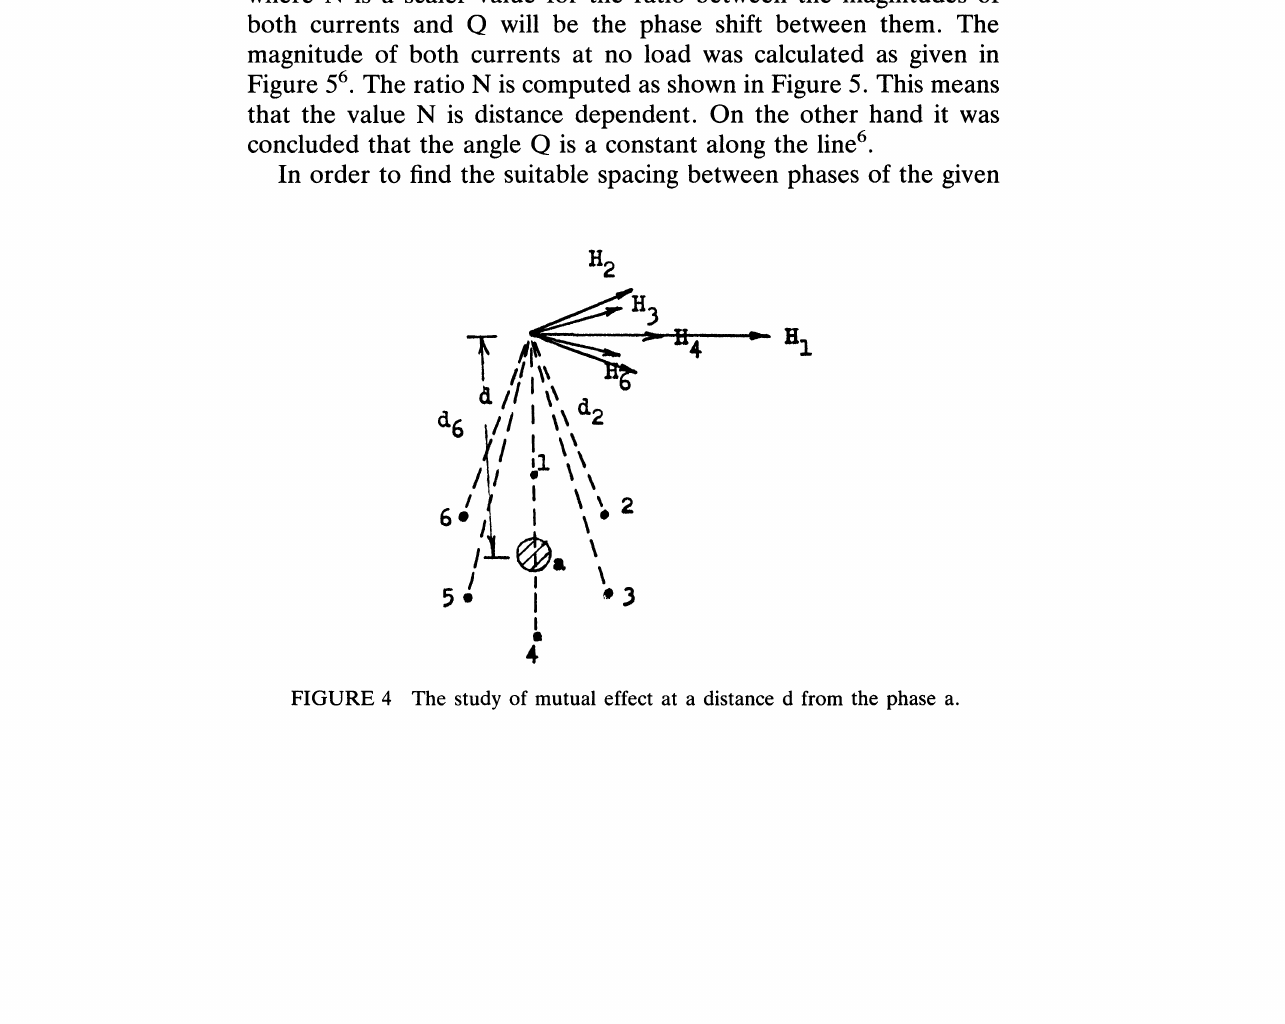
FIGURE 4 The study of mutual effect at a distance d from the phase